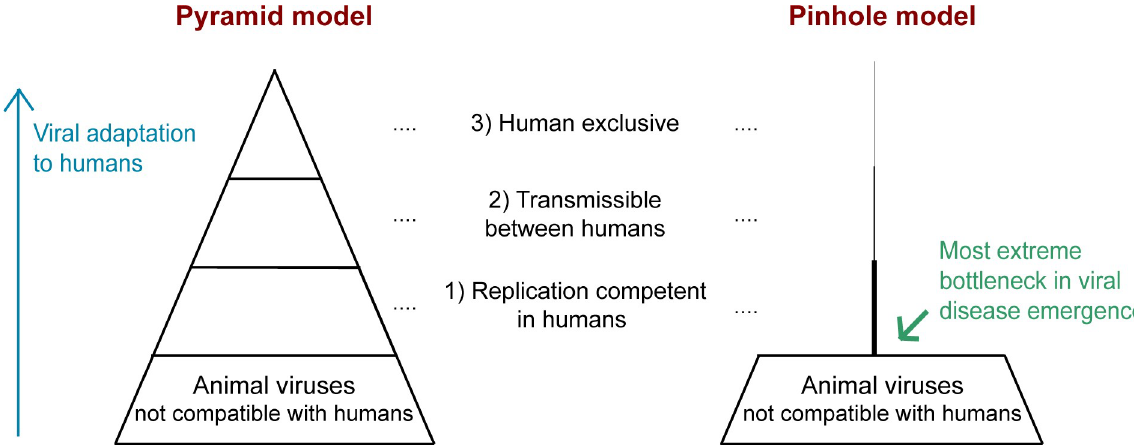
Fig 1. This essay focuses on the most extreme bottleneck in viral disease emergence: The replication of animal viruses in their first human host. On the left is a typical representation of the zoonosis pyramid, modified from [1,3–5].The concept here is that animal viruses become increasingly human-adapted through a series of evolutionary steps represented from bottom to top. In our view, these steps are best described as 1) random variants arise in the animal reservoir that are capable of replicating themselves in humans, 2) variants are then selected for the ability to transmit between people, and 3) sometimes, as in the case of HIV-1 group M [12], these viruses become stably maintained in humans and are divorced from their former animal reservoir. The pyramid shape properly demonstrates that increasingly fewer viruses progress through the different stages of zoonosis but is misleading in that it doesn’t represent the scale of probabilities in these events. Instead, based on the arguments laid out in the essay, the pyramid should more correctly be depicted as a pinhole. As shown on the right, our current understanding is that < 0.1% of animal viruses have any ability to replicate in humans (step 1), and then fewer still are able to meet the relevant criteria as the process continues upwards. The bottlenecks leading to the latter two steps don’t seem to be as extreme. One study of zoonotic pathogens (those already at step 1) found that 33% are transmissible between humans (step 2), and 3% spread so effectively that they become permanently sustained in humans (step 3) [10]. Herein, we discuss how experimental virology and an understanding of host–virus interactions render clear the reasons for the most extreme bottleneck in this process (green